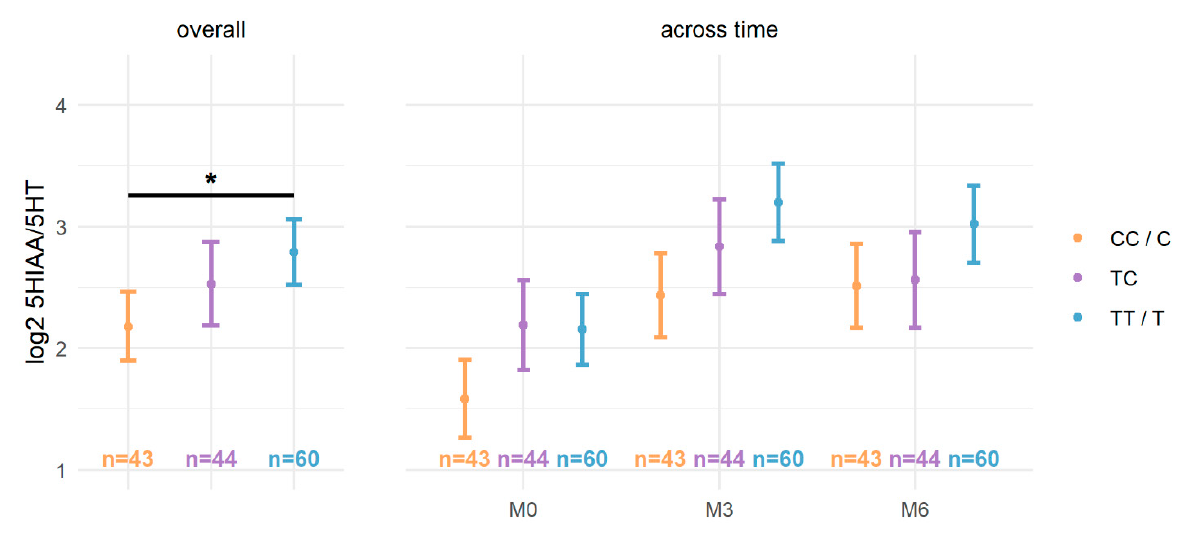
Figure 2. Log 2 5HIAA/5HT ratios according to MAOB rs1799836 genotypes. The log 2 5HIAA/5HT ratio (y-axis) according to rs1799836 genotypes (see legend) both overall (left) and across time * p < 0.05 following Bonferroni correction for the three (right). * p < 0.05 following Bonferroni correction for the three comparisons.